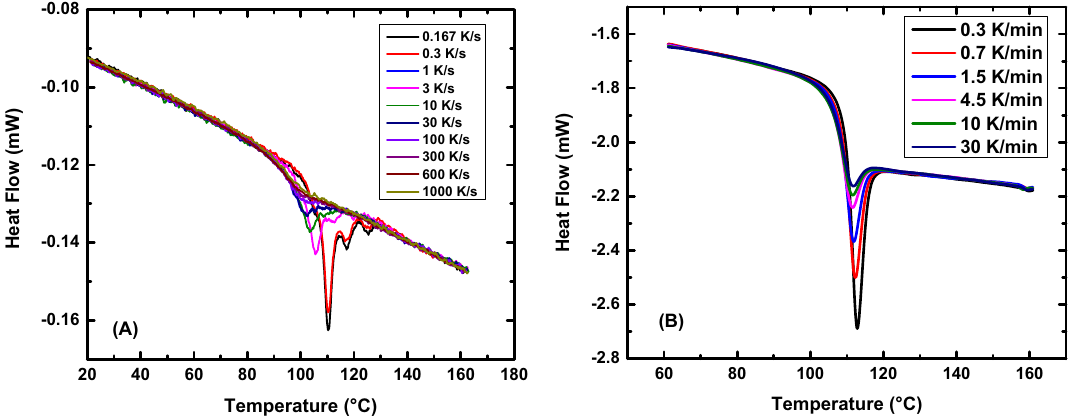
Figure 4. Heat flow curves at various cooling rates. ( A ) Heat flow scans for a 210 nm rejuvenated VPD film deposited at 0.85T g and ( B ) heat flow scans for a 15.76 mg sample of virgin material.